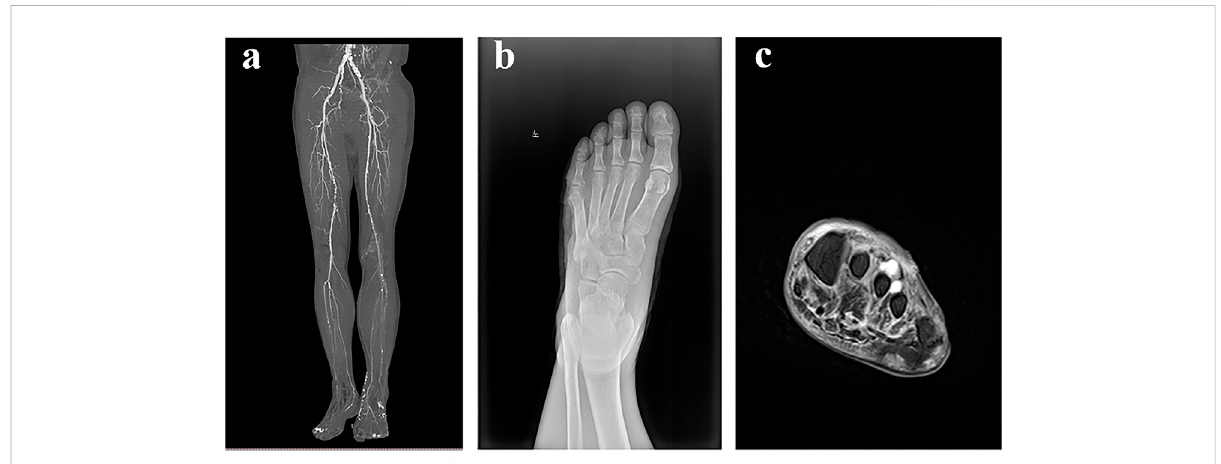
FIGURE 2 Aidstotheexamination. (A) :Below-kneeCTAshowedthatlowerlimbswitharteriosclerosisandlumenhadvariousdegreesofstenosis. (B) Foot skew radiographs showed that the soft tissue density of the lateral left foot was non-uniform and locally absent. (C) Foot MRI showed that there was no obviousabnormality in the left bone marrow, plantar and dorsal regions of thefoot muscle gap had a fl occulently visible signal on T2, and plantar fascia thickening.